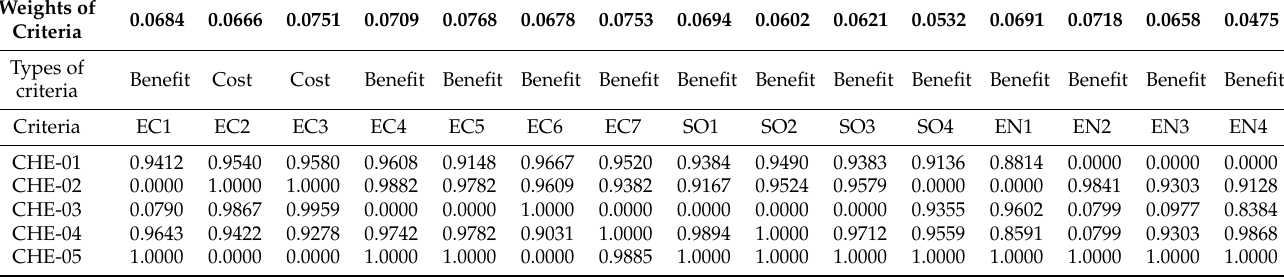
Table A3. The exponentially weighted comparability sequence matrix of the CoCoSo